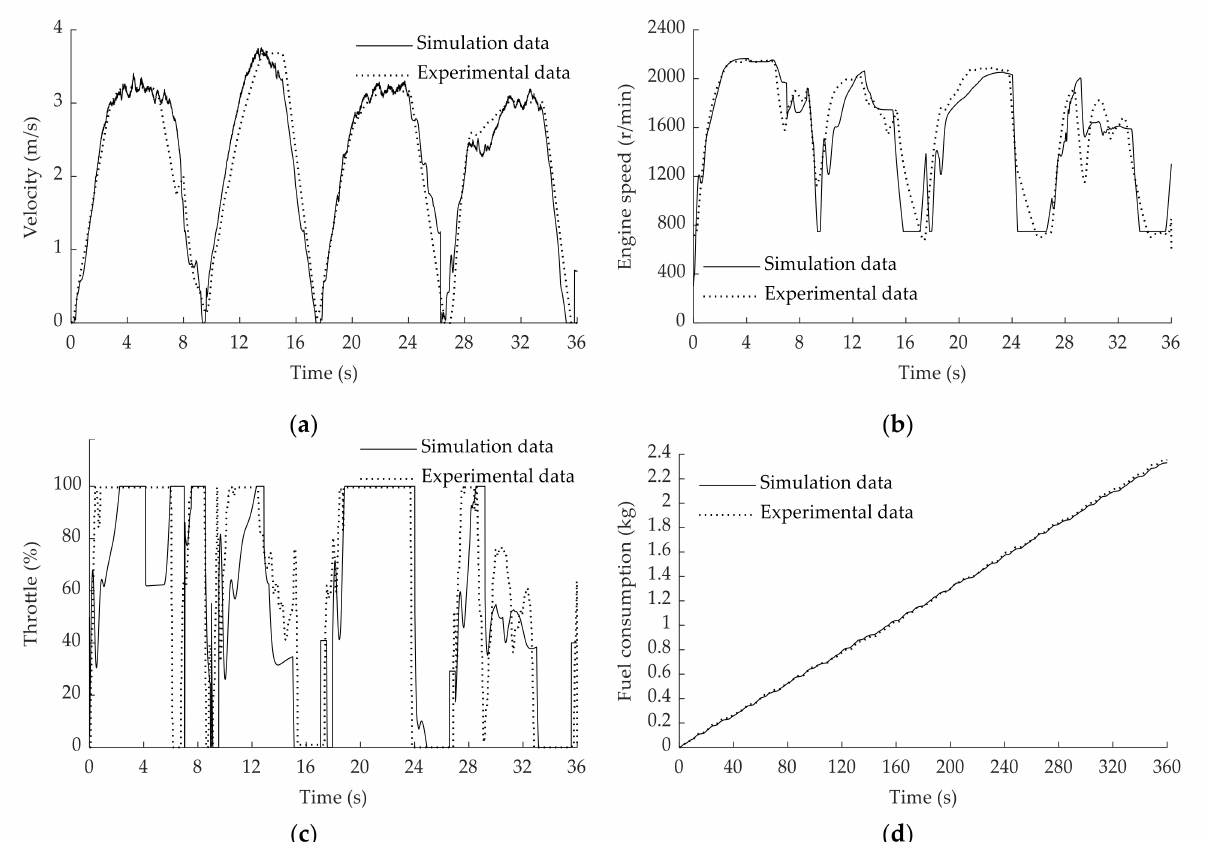
Figure 11. Simulation results. ( a ) velocity; ( b ) engine speed; ( c ) throttle; ( d ) fuel